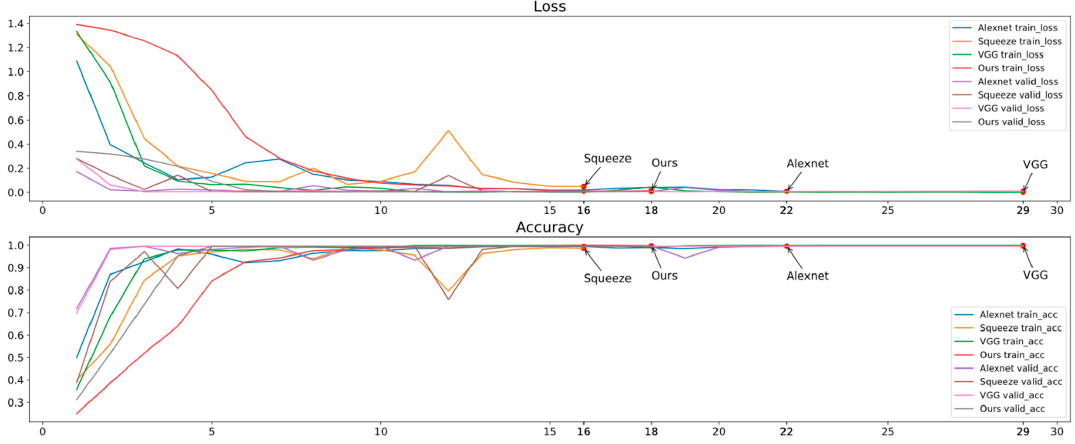
Figure 8. Training loss and Validation loss ( Up ) and accuracy ( Down ) rate according to epoch number in the experiment. Table 5. Results of the models proposed in this paper and existing deep learning models learned based on data with noise.